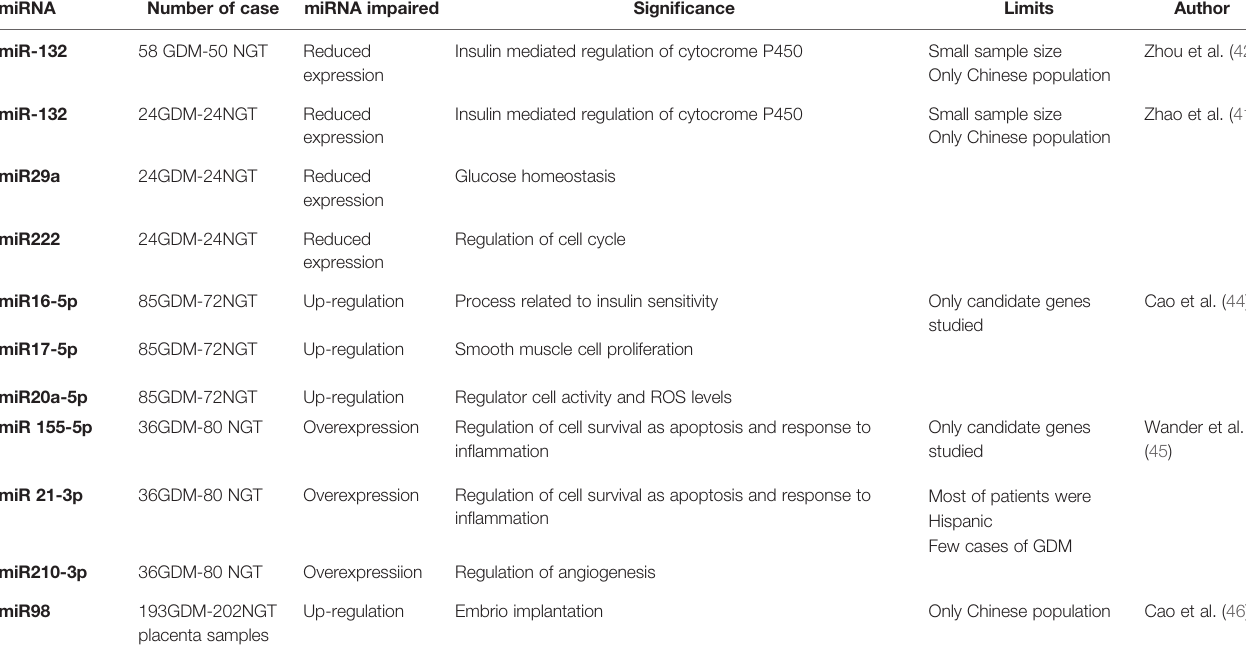
TABLE 4 | Studies assessing the role of mRNAs in gestational diabetes (GDM) and Normal Glucose Tolerance (NGT). miRNA Number of case miRNA impaired Signi fi